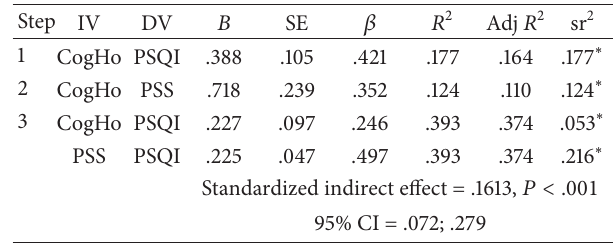
Table 3: Cognitive hostility and the PSQI mediated by